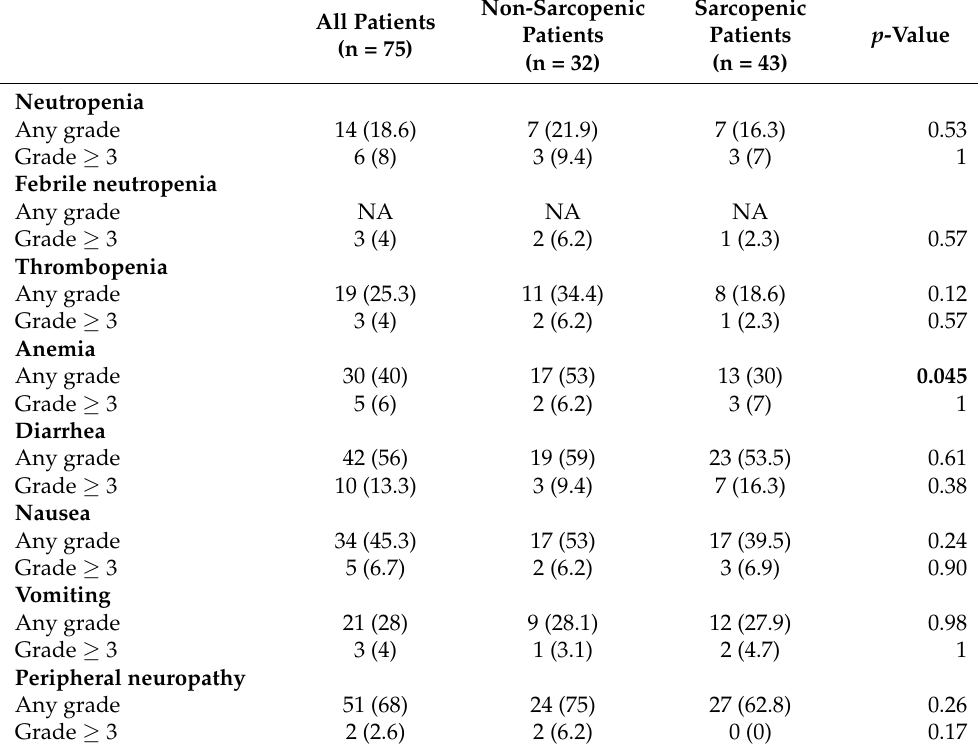
Table 2. Toxicity in patients receiving FOLFIRINOX regimen for metastatic pancreatic